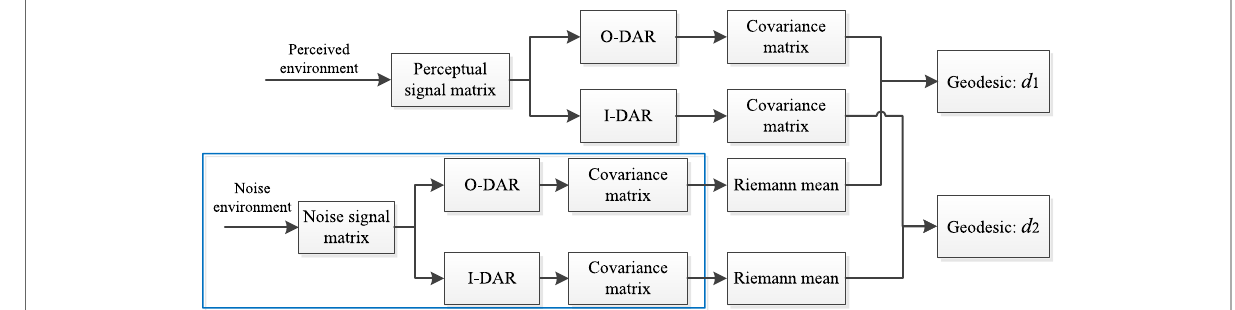
Fig. 2 Feature extraction